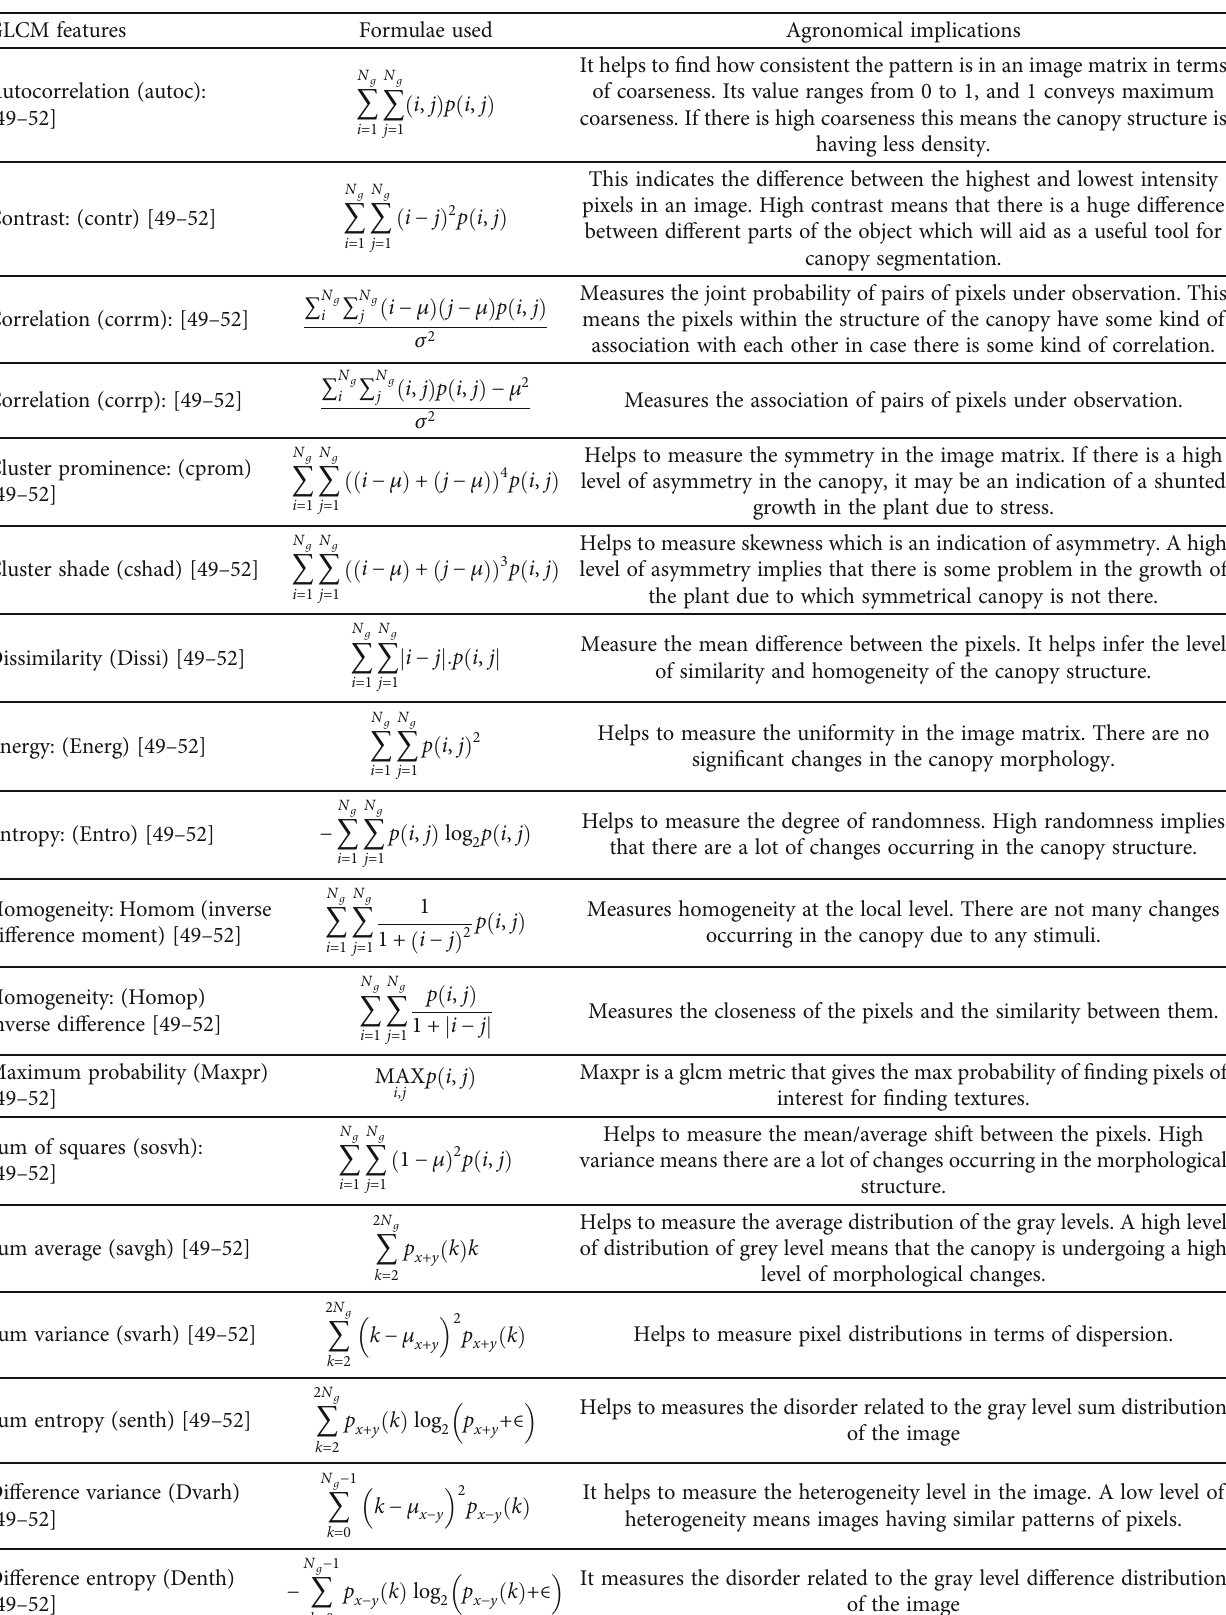
Table 2: Description of glcm metrics that de fi ne wheat canopy